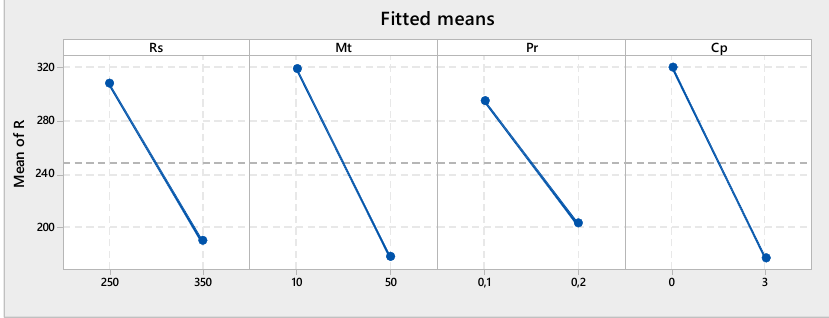
Figure 4. Main effect analysis of milling parameters: Rs , Mt , Pr , Cp for the experimental design.